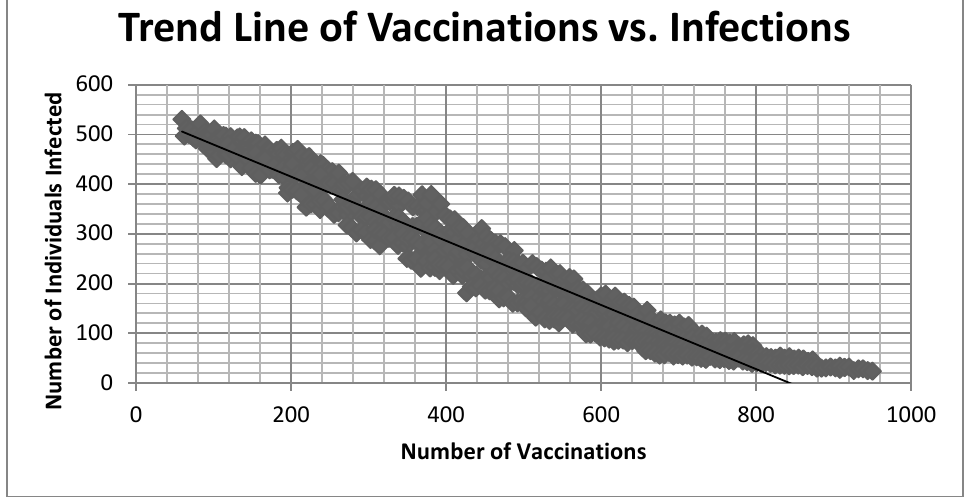
Figure 1. Plot of the number of individuals infected as a function of the total number of vaccinations performed in all groups. A trend line is plotted vs. the data.